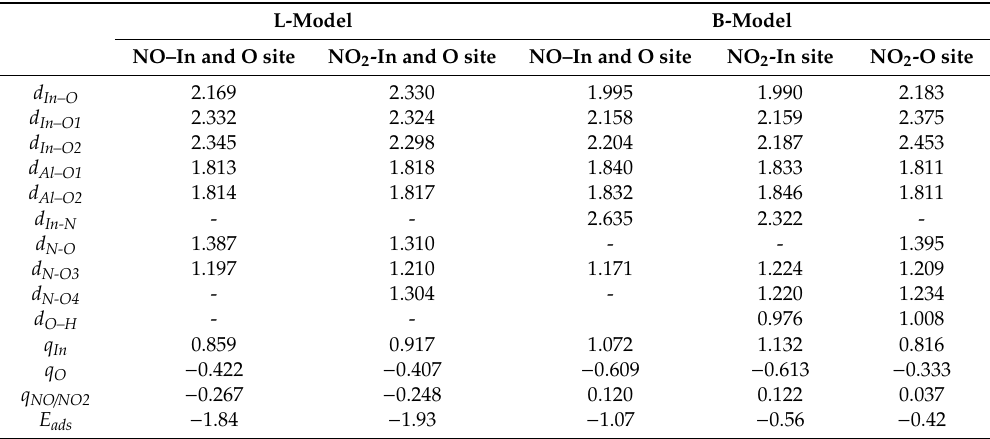
Table 4. Bond length ( d , Å), Mulliken charge population ( q , e) and adsorption energy (Eads, eV) of NO and NO 2 adsorption on In /